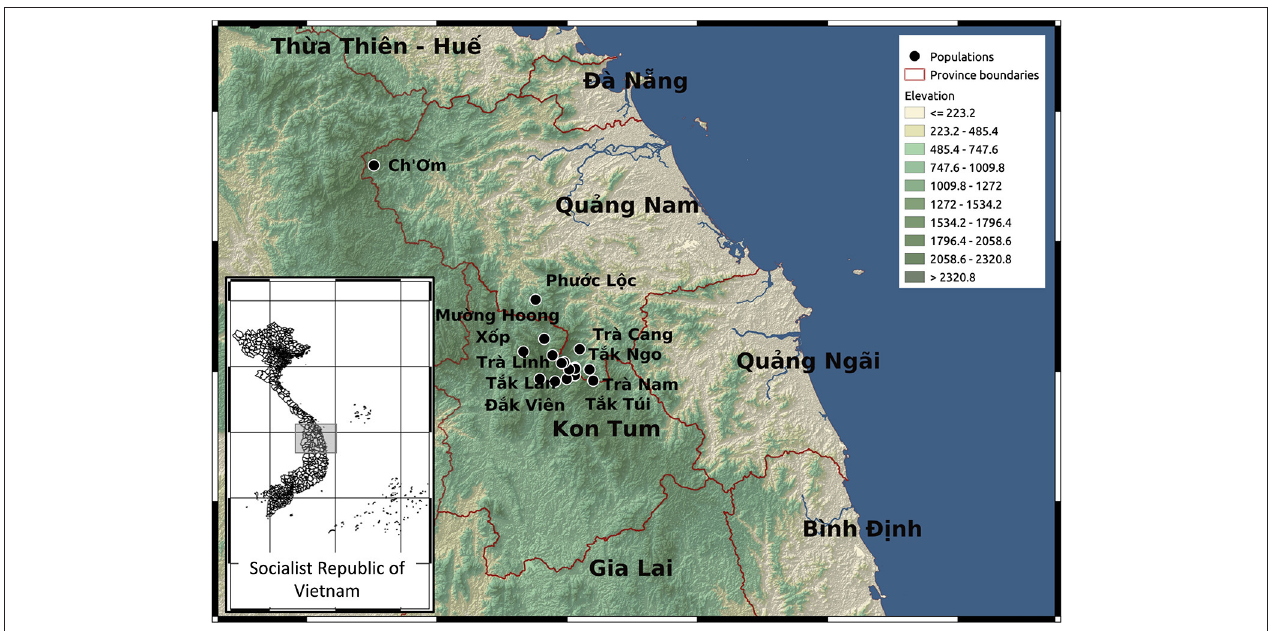
FIGURE 1 | Topographic map showing the provinces and study sites in